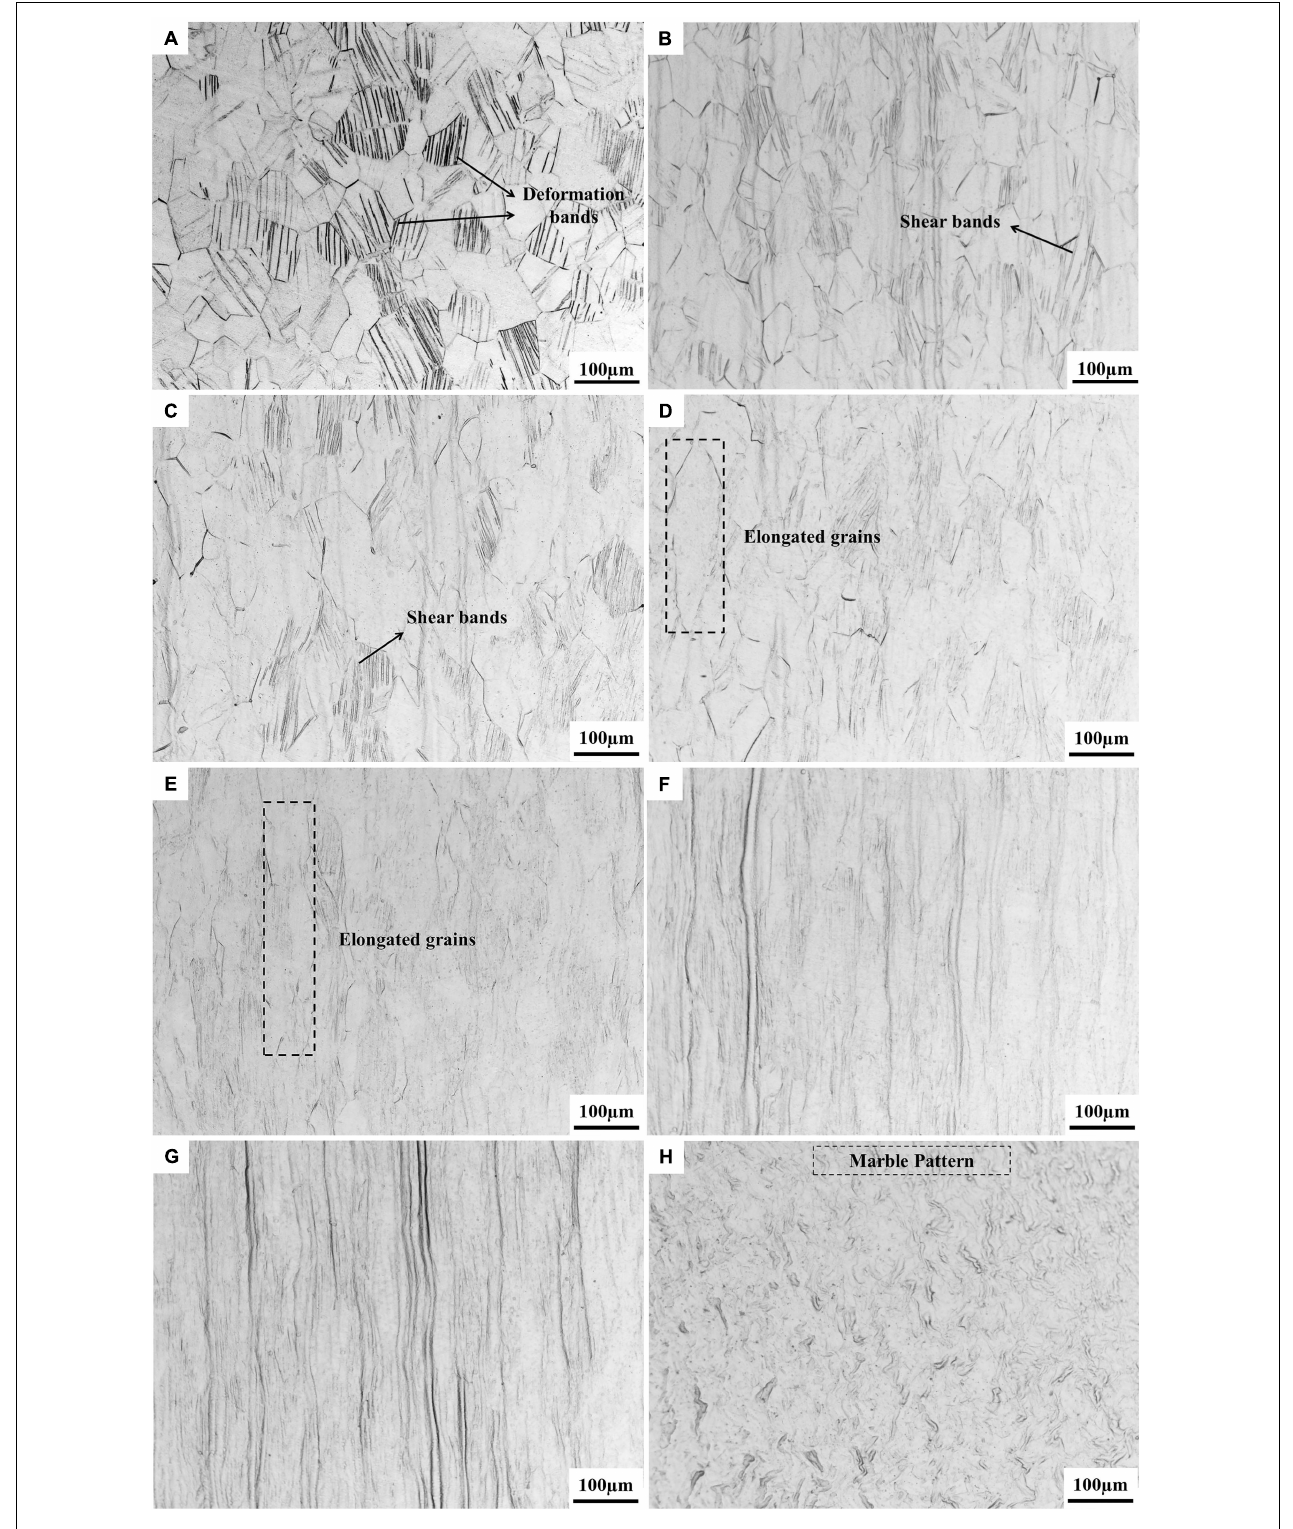
FIGURE 2 | Optical microstructures of the Ti–10Mo–6Zr–4Sn–3Nb alloy cold swaged with reductions of: (A) 15%, (B) 25%, (C) 35%, (D) 45%, (E) 55%, (F) 65%, and (G,H) 75%. The samples of (A–G) were taken from the longitudinal section of the alloy bars; The sample of (H) was cut from the cross section of the experimental alloy